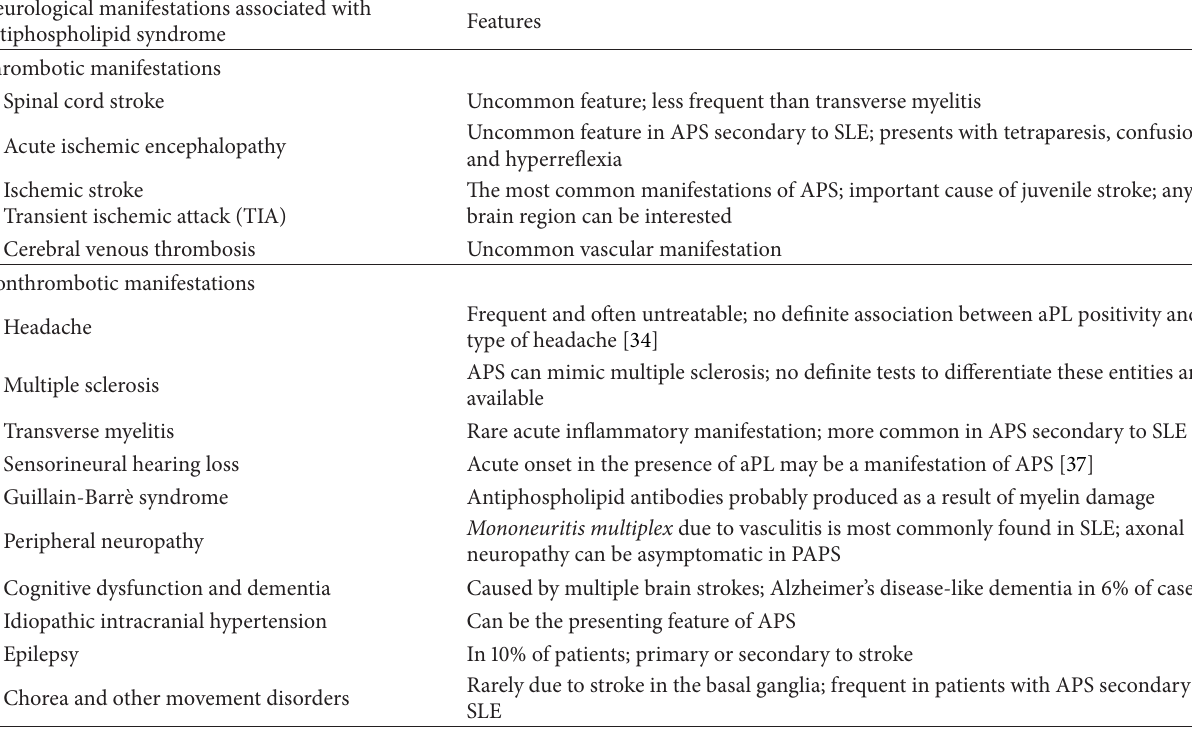
Table 1: Neurological manifestations of